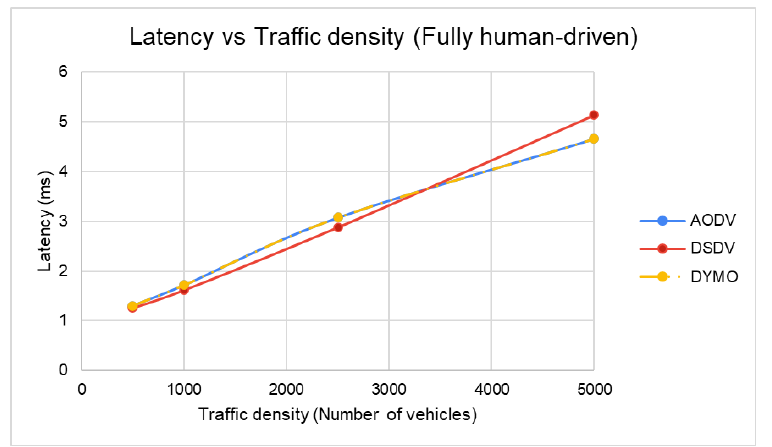
Figure 12. Latency graph for fully human-driven vehicles with varying traffic